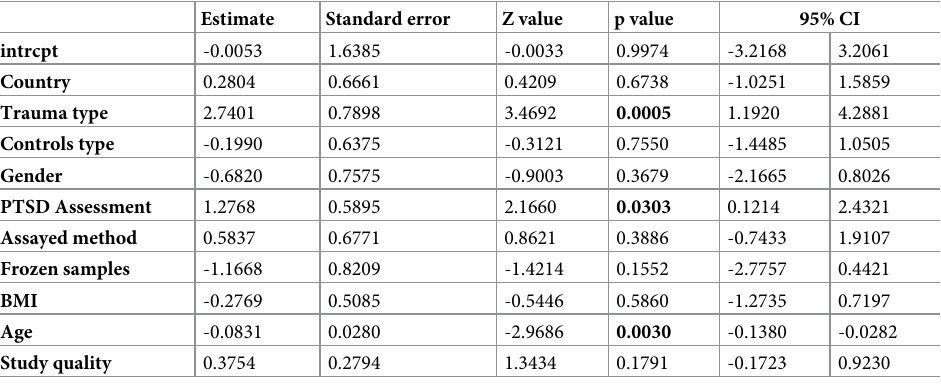
Table 3. Separate univariate meta-regression model of 24-h urinary cortisol in PTSD.